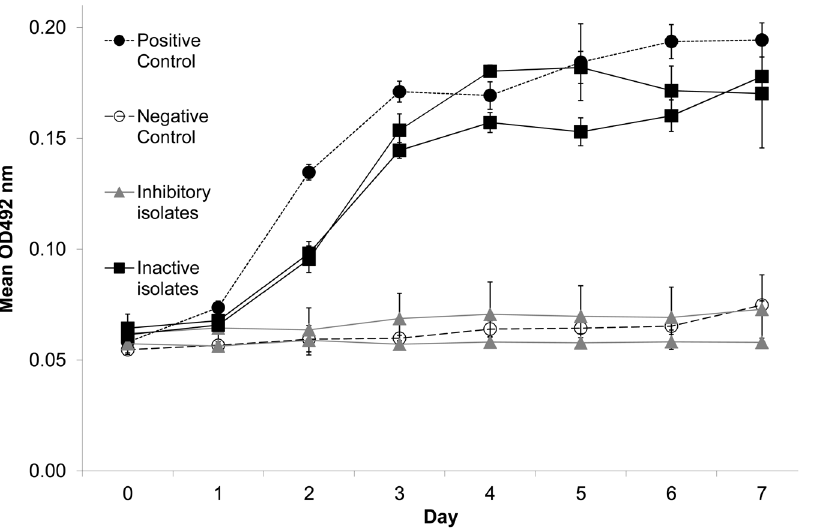
Figure 2. Example growth curves ± SD of the positive control, the negative control, two inactive, and two strongly inhibitory cell- free supernatants from an initial screening assay. Higher optical density at 492 nm (y-axis, OD 492 ) indicates greater Bd growth. Day 0 OD 492 varies with original cell-free supernatant color, which is corrected for in calculations (see Methods).